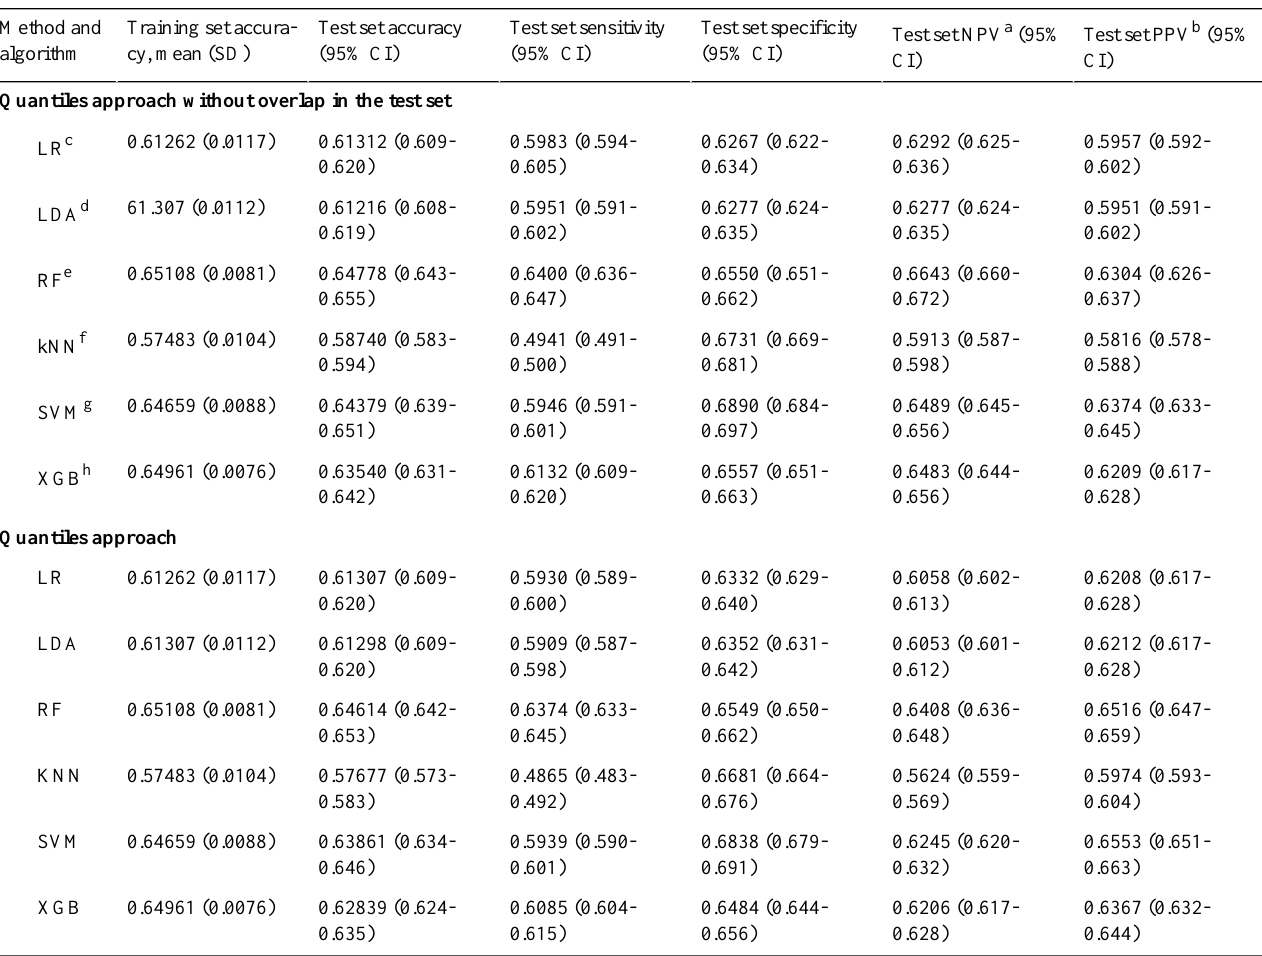
Table 14. Length of stay model results for six algorithms using different performance